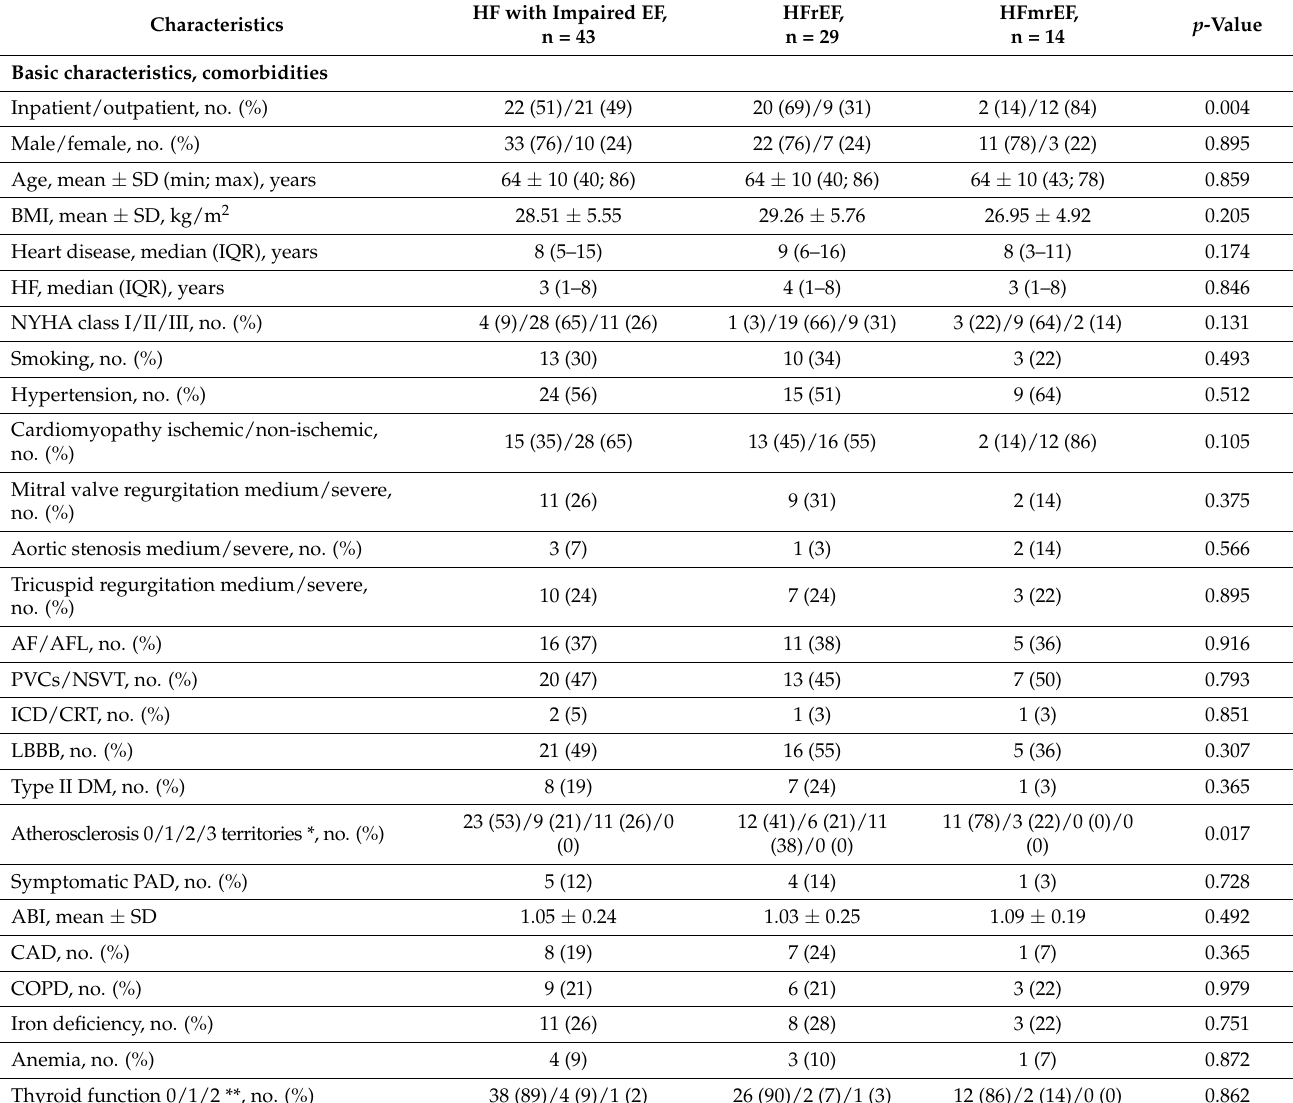
Table 1. Clinical, laboratory, and ultrasound variables in HF